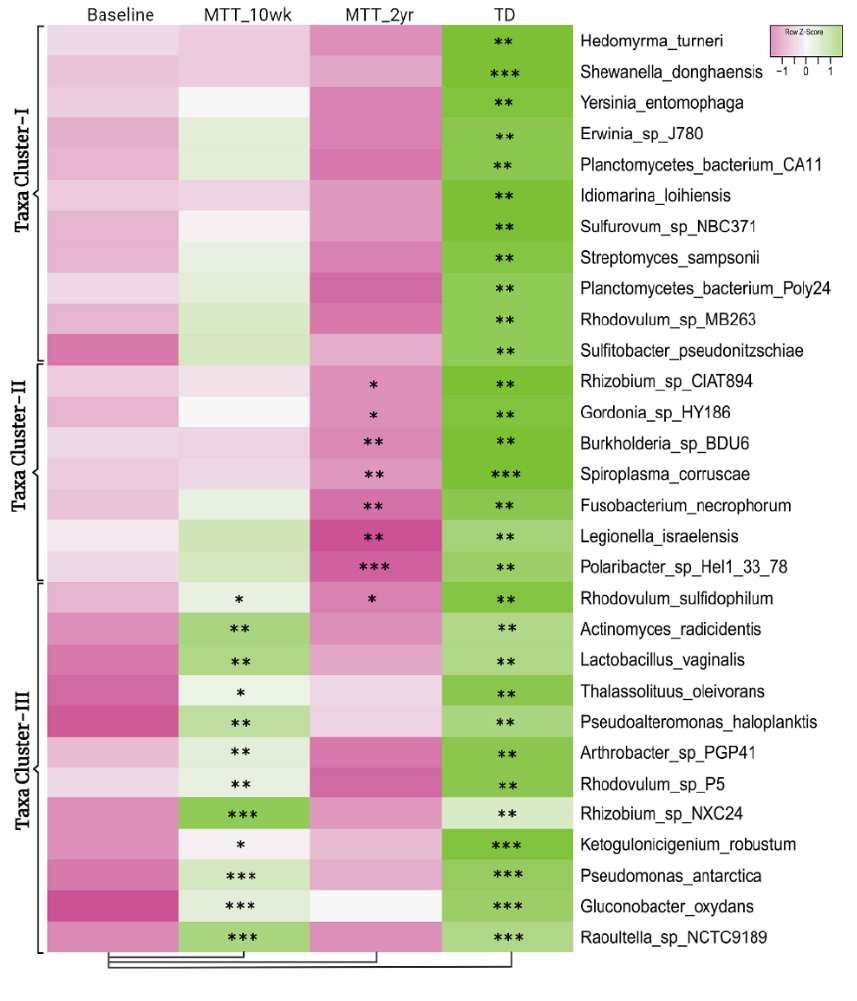
Figure 2. Univariate comparison of the (z-score) relative abundance of gut bacteria for the ASD Baseline group vs. all other groups. Top 30 bacterial species in three clusters that had significantly different relative abundance at Baseline vs. TD (cutoff p < 0.01, adjusted p < 0.05). Median of bacterial relative abundance was used to construct the heatmap for each group. * Single asterisk indicates p < 0.05, ** double asterisks indicate p < 0.01, triple *** asterisks indicate p < 0.001. All p -values are FDR-corrected. ASD: autism spectrum disorder; TD: typically developing.